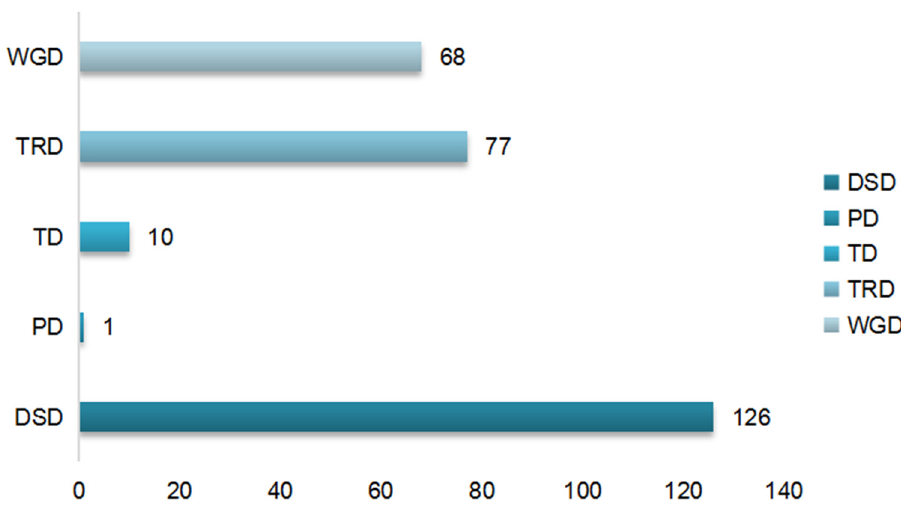
Figure 6. The duplication types of SUV gene family in B. napus , B. rapa and B. oleracea .